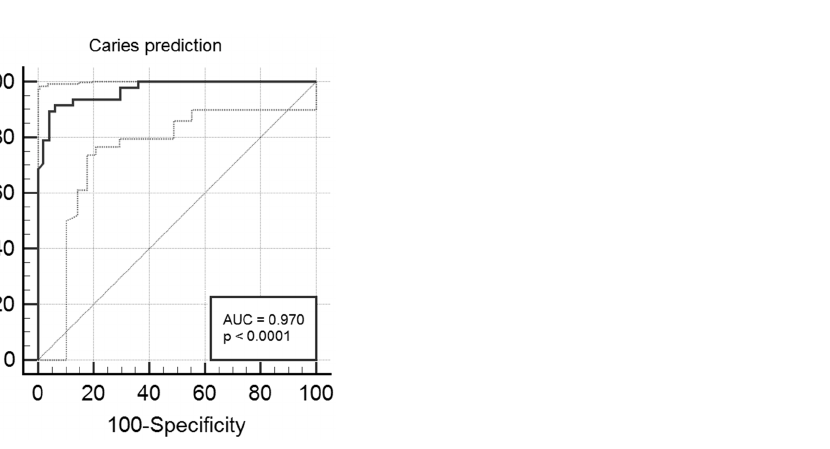
Figure 1. The receiver operator characteristic (ROC) curve analysis and area under the receiver operating characteristic (AUC) value. The solid black line indicates the ROC curve based on 8 variables, i.e., rs10429371, rs7096206, rs12640848, rs17878486, rs12640848, rs2337360, rs2235091 and rs198969, and the true positives (sensitivity) and false negatives (100-specificity) for caries prediction when compared to the actual data. The dashed lines indicate the ROC curves for 95% Confidence Interval. According to other mathematical algorithms used in neural network analysis, all eight variables that performed at p < 0.05 in univariable analyses were also introduced in the NN model, although only three of them hold the significance in multivariable logistic regression. The overall performance of six neural network prediction models is presented in Table 9. Table 9. The overall performance for 6 neural network models for caries prediction.